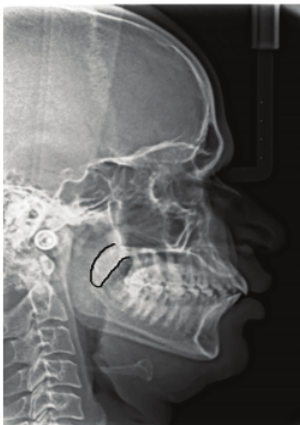
Figure 3: Lateral cephalogram depicting type 3 (butt shape) pattern of soft palate.